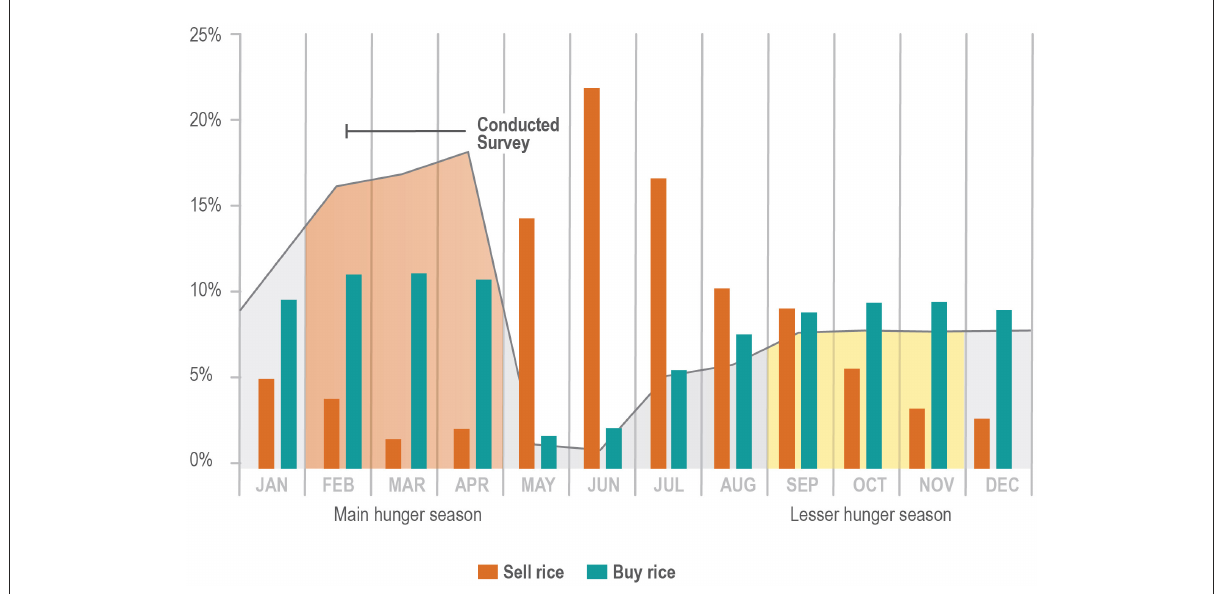
FIGURE3 Percentage of farmers buying and selling rice per month; Percentage of households reporting food insecurity by month. Black line indicates 3-week time period in which survey was conducted, which is the beginning of the “hunger season” in which rice stores run low or are completely